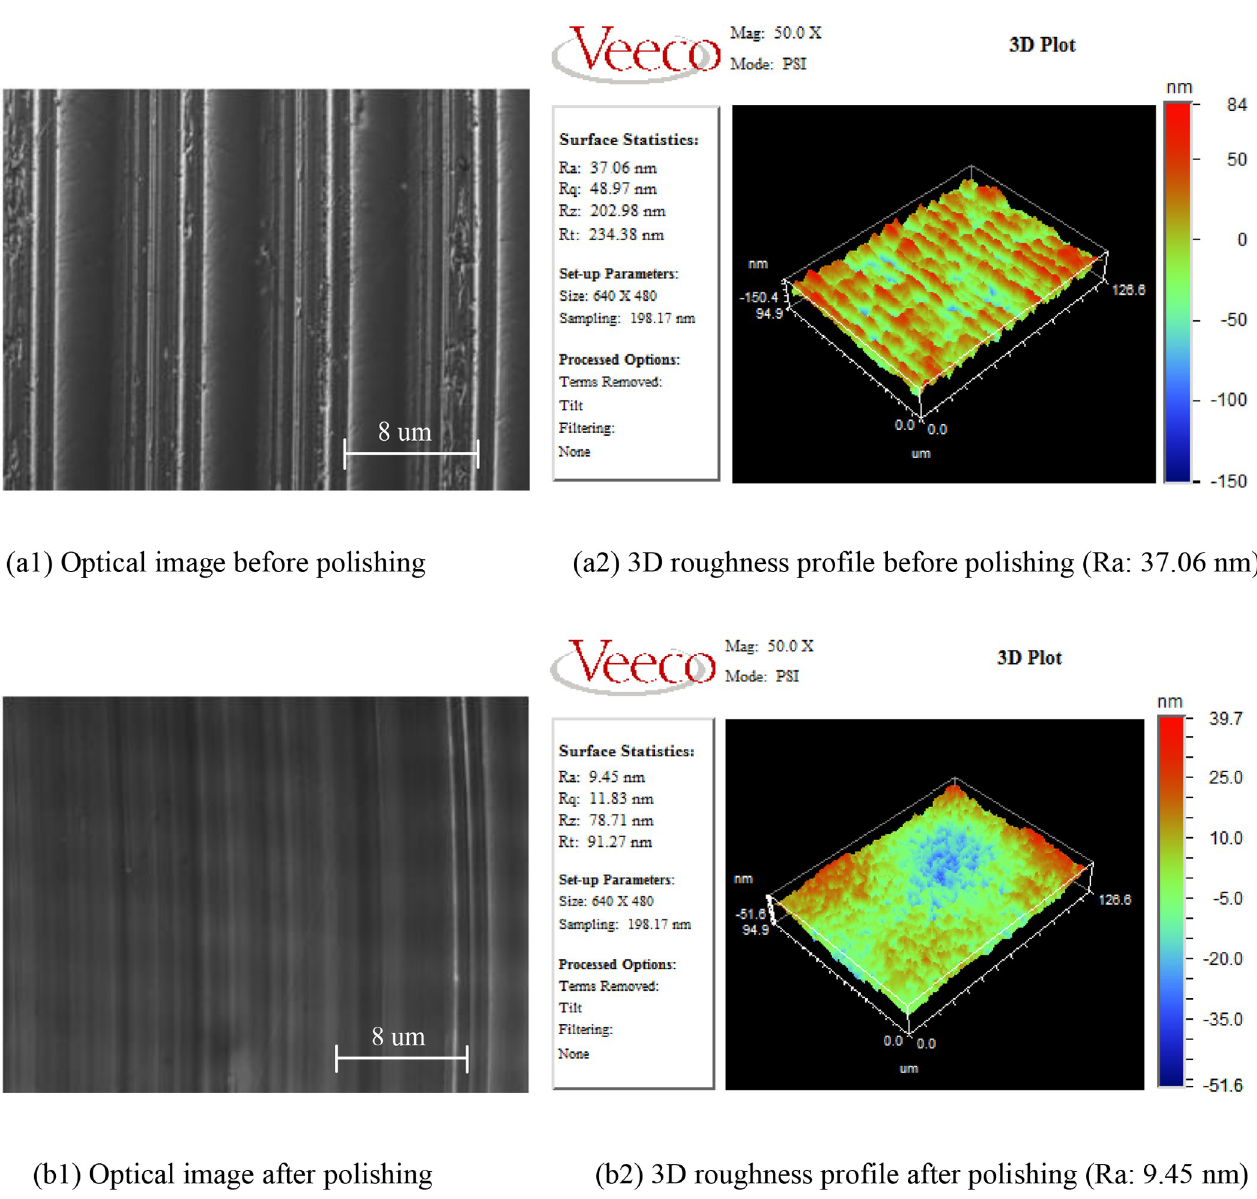
Fig 4. Comparison of surface profiles of one Ti6Al4V sample before and after polishing. https://doi.org/10.1371/journal.pone.0272387.g004 significantly and fell below 10 nm after ultra-precision polishing. The results reveal that the roughness values of the Ti6Al4V samples reached the optical demands. However, the values of surface roughness had no obvious differences under different feeding speeds. In addition, the roughness values of the four Ti6Al4V samples were greater than 5 nm. As can be seen from the X and Y directions of the surface profile, there are no excessive peaks in the profile and most of the residual height has been removed by the ultra-precision polishing process. At the same time, the results show that ultra-precision polishing can reduce the surface roughness, but the feed speed is not the main parameter affecting the surface quality. When the cutting depth is larger, the contact area between the polishing bonnet and workpiece is larger, and the effect of feed speed is not obvious. The results are in good agreement with those in the literature [31].